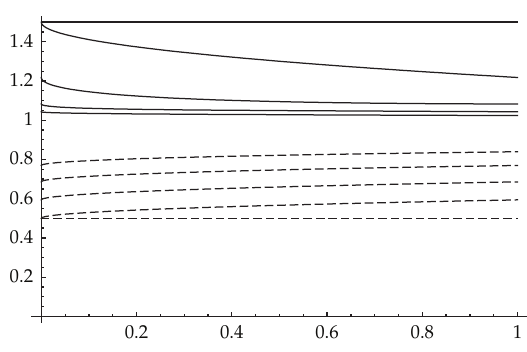
Figure 1: Dashed: { v 2 n ,w 2 n (cid:9) 1 } . Solid: { w 2 n ,v 2 n (cid:9) 1 }